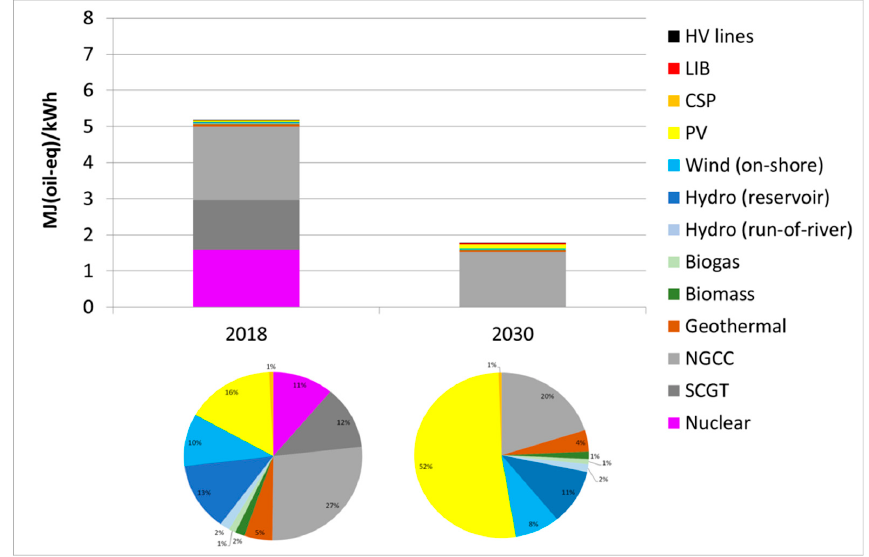
Figure 9. Non ‐ renewable cumulative energy demand (nr ‐ CED) results for California domestic grid mix in 2018 and in 2030. The pie charts underneath each bar refer to the corresponding grid mix composition, and are included to aid the interpretation of the results. SCGT = single cycle gas turbines; NGCC = natural gas combined cycles; PV = photovoltaics; CSP = concentrating solar power; LIB = lithium ‐ ion batteries; HV = high voltage.